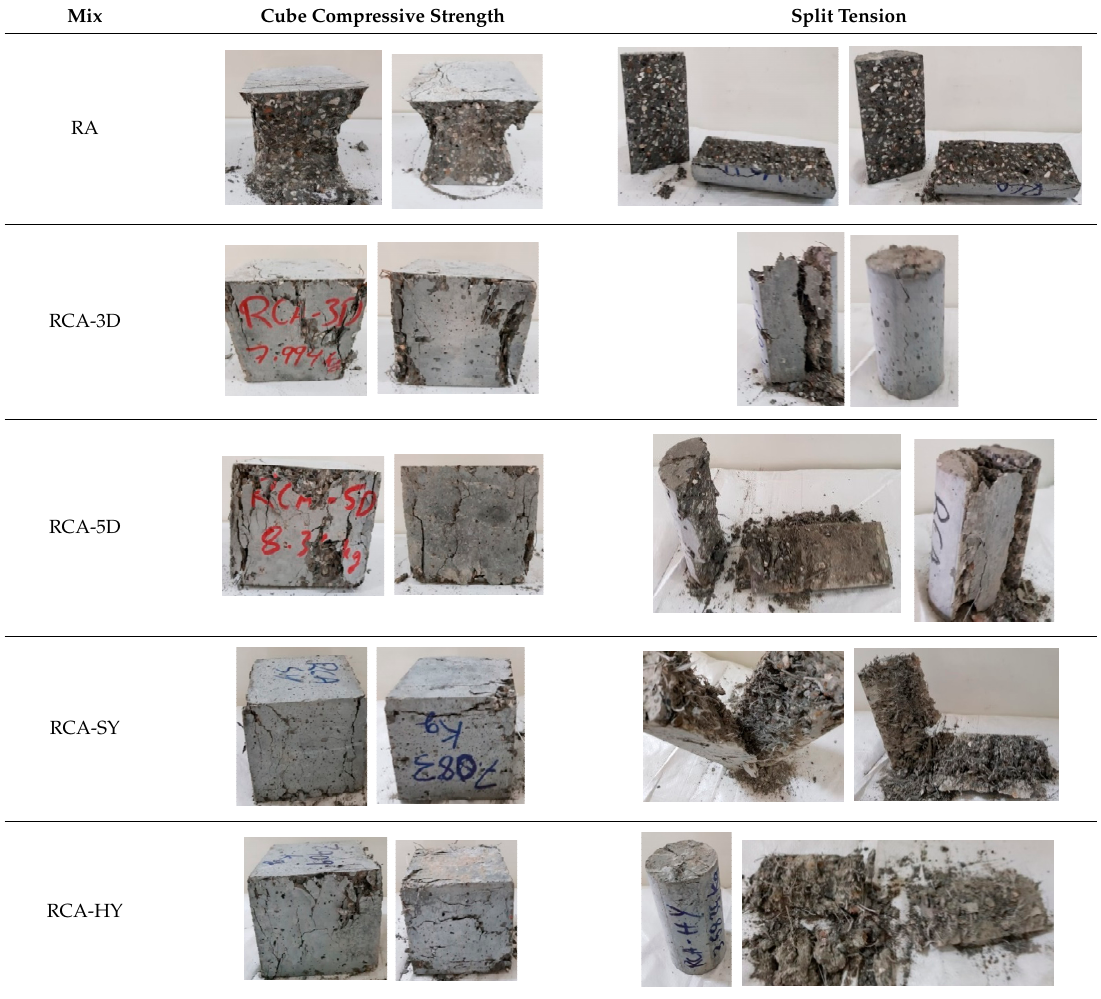
Table 8. Failure modes of cube and cylinder specimens from all mixes.